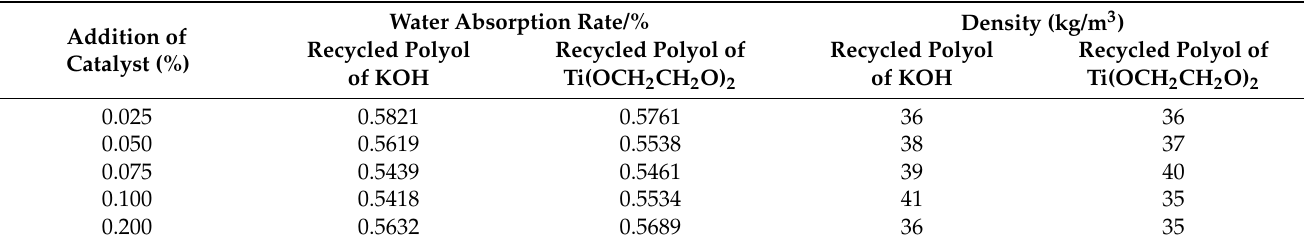
Table 3. Determination of water absorption and density of regenerated polyurethane foam under different catalytic